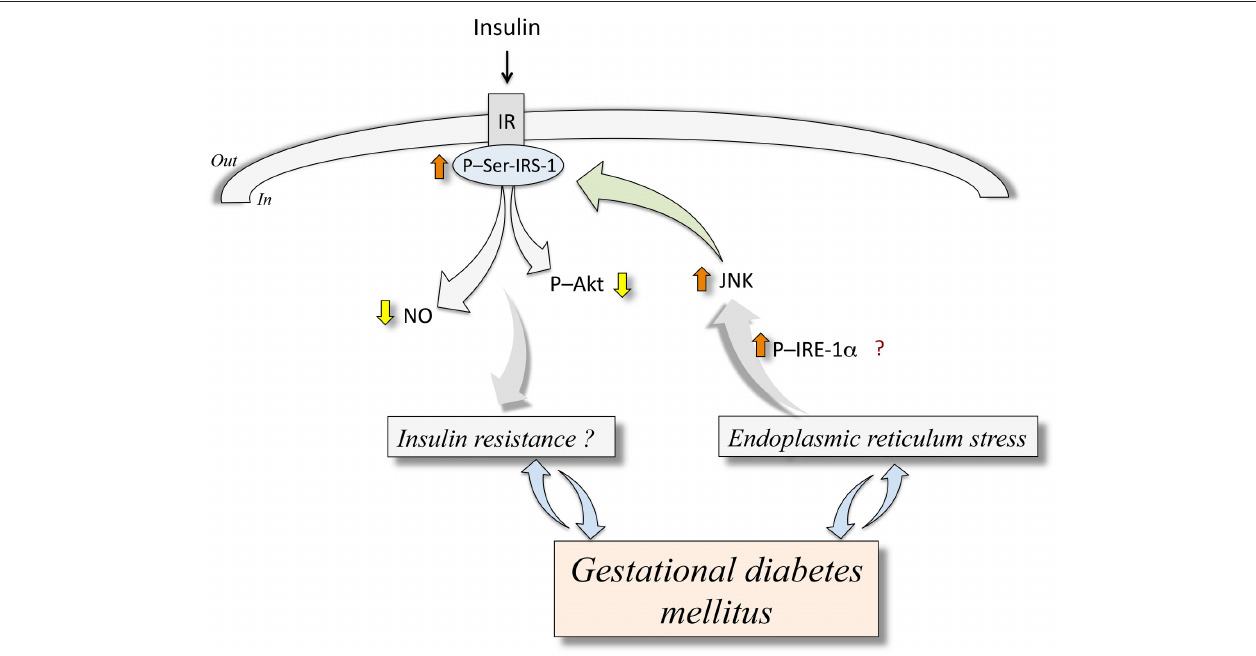
FIGURE 1 | Endoplasmic reticulum stress and abnormal insulin signaling in human fetoplacental endothelium from gestational diabetes mellitus. Gestational diabetes mellitus is a disease that associates with endoplasmic reticulum stress (ERS). The latter is an abnormal metabolic condition that could (?) lead to increased ( ) phosphorylation of inositol-requiring enzyme 1 α (P-IRE-1 α ) resulting in higher c-Jun N-terminal kinase (JNK) activity. This phenomenon causes phosphorylation of insulin receptor substrate 1 at serine 307 (P-Ser-IRS-1) ending in lower insulin receptor (IR)-associated cell signaling in response to insulin.